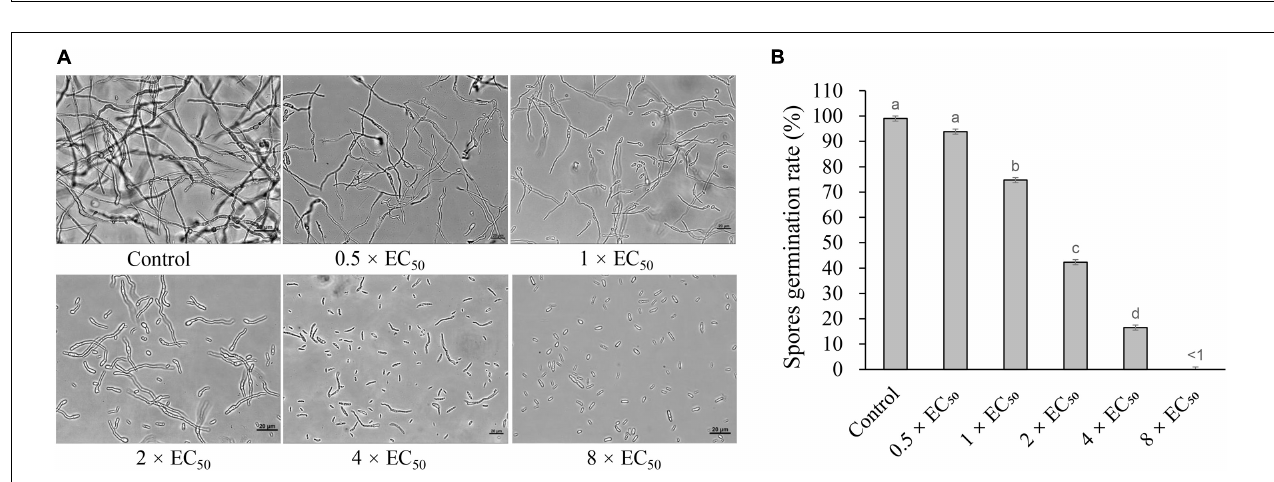
FIGURE 5 | Mycelial cell ultrastructure of Foc TR4 observed under TEM. (A) Ultrastructure characteristics of Foc TR4. (B–D) Ultrastructure characteristics of Foc TR4 treated with 50 µ g/ml of strain H3-2 extracts. The arrows indicate Foc TR4 ultrastructure damaged by strain H3-2 extracts. Bar = 2 µ m.